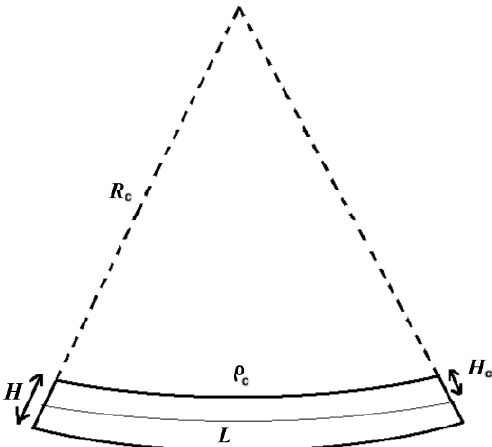
Fig. 3 Geometric parameters of the beam used to determine the neutral axis position (Eq. (7)) in four-point bending specimens.